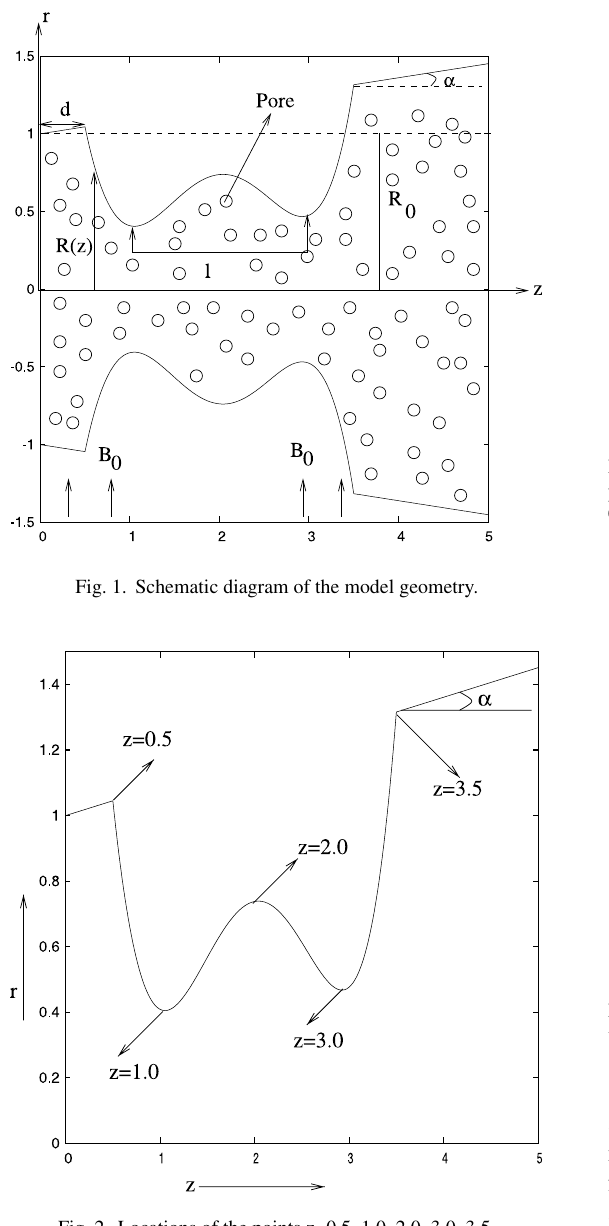
Fig. 2. Locations of the points z=0.5, 1.0, 2.0, 3.0, 3.5.